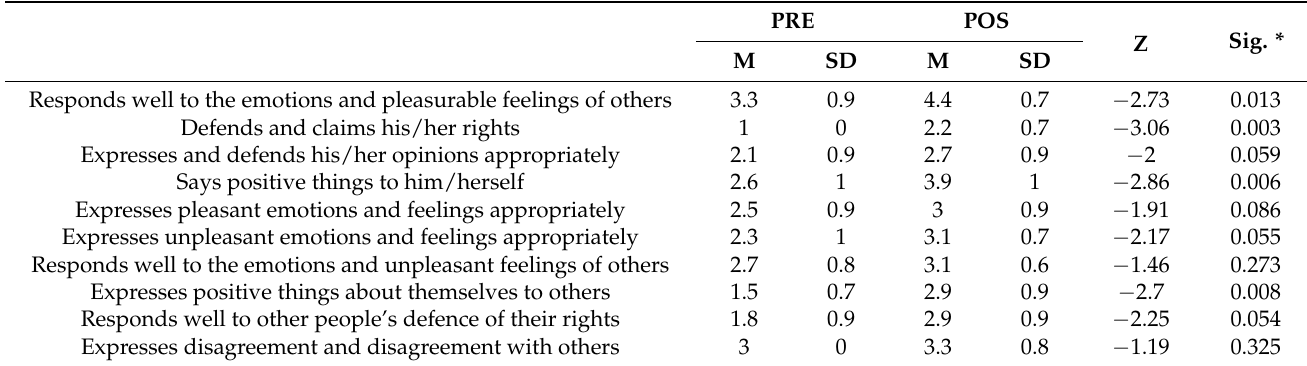
Table 4. Skills related to emotions and feelings.